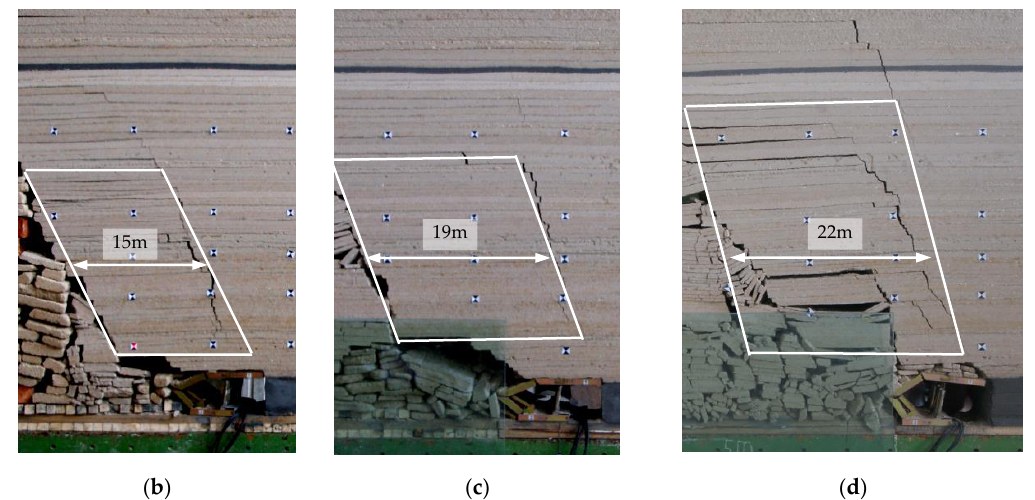
Figure 7. Simulated the mining height at 4 m, 5 m, and 6 m: ( a ) physical simulation model, ( b ) the mining height is 4 m, ( c ) the mining height is 5 m, and ( d ) the mining height is 6 m. Figures 7 and 8 show the DPC evolution under different mining heights. The height is the only variable. As the mining height increases, the periodical weighting intervals and the range of cracks and the crack development speed grow.